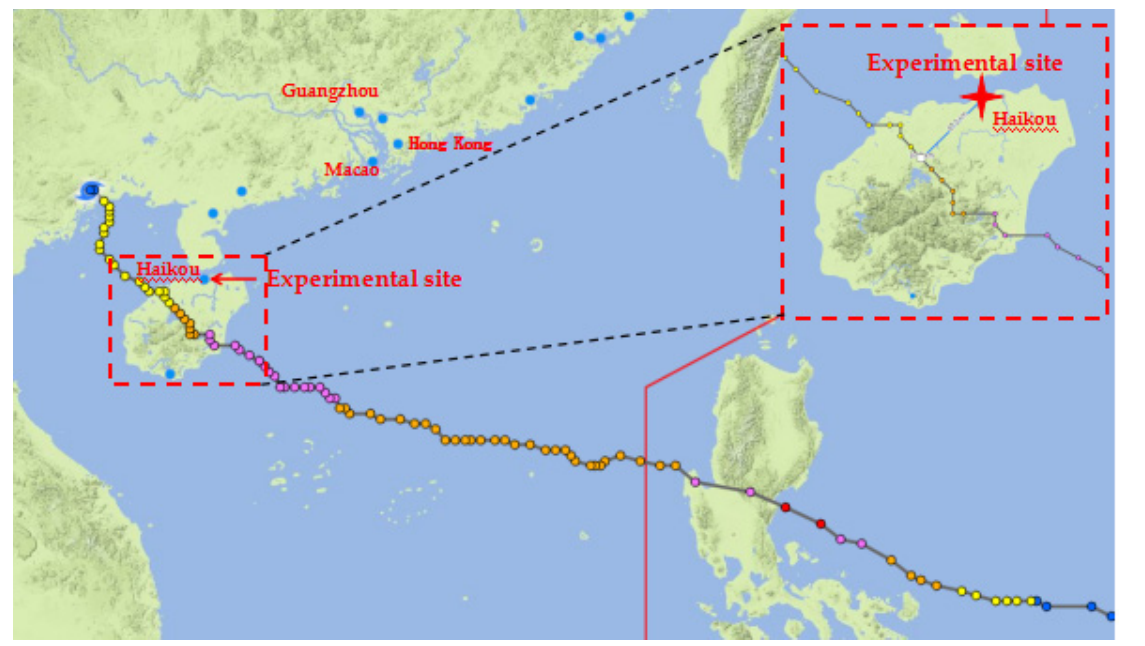
Figure 1. Track of typhoon Sarika and the ambient condition of experimental site.